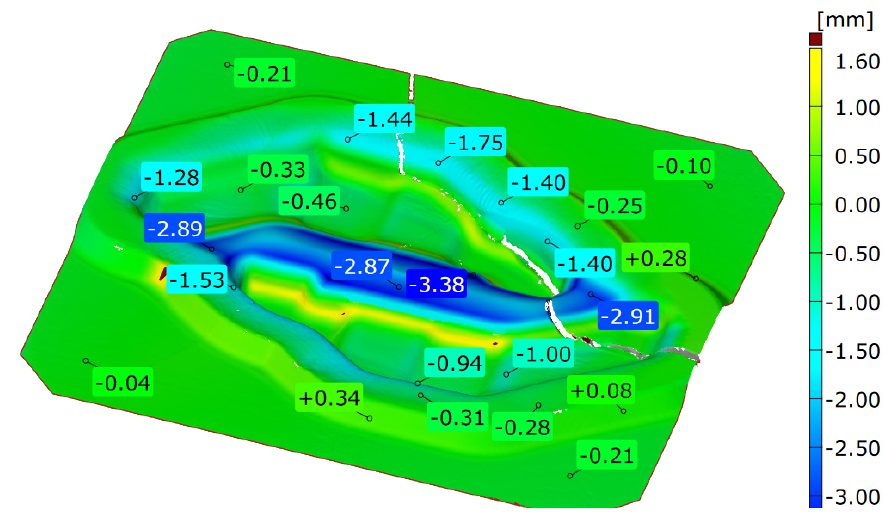
Figure 2. The results of the scan analysis of the used tool.